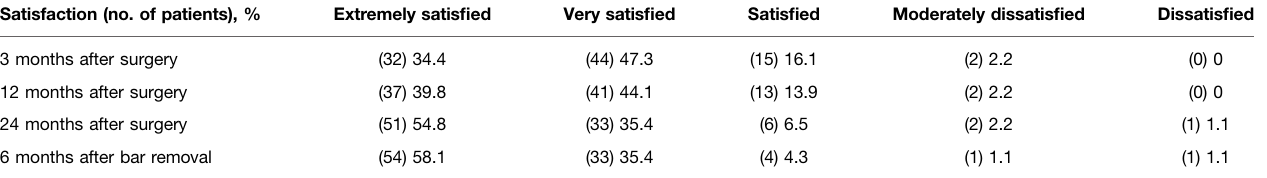
TABLE 2 | Results of the satisfaction questionnaire after minimally invasive repair of pectus excavatum (MIRPE). Satisfaction (no. of patients), %